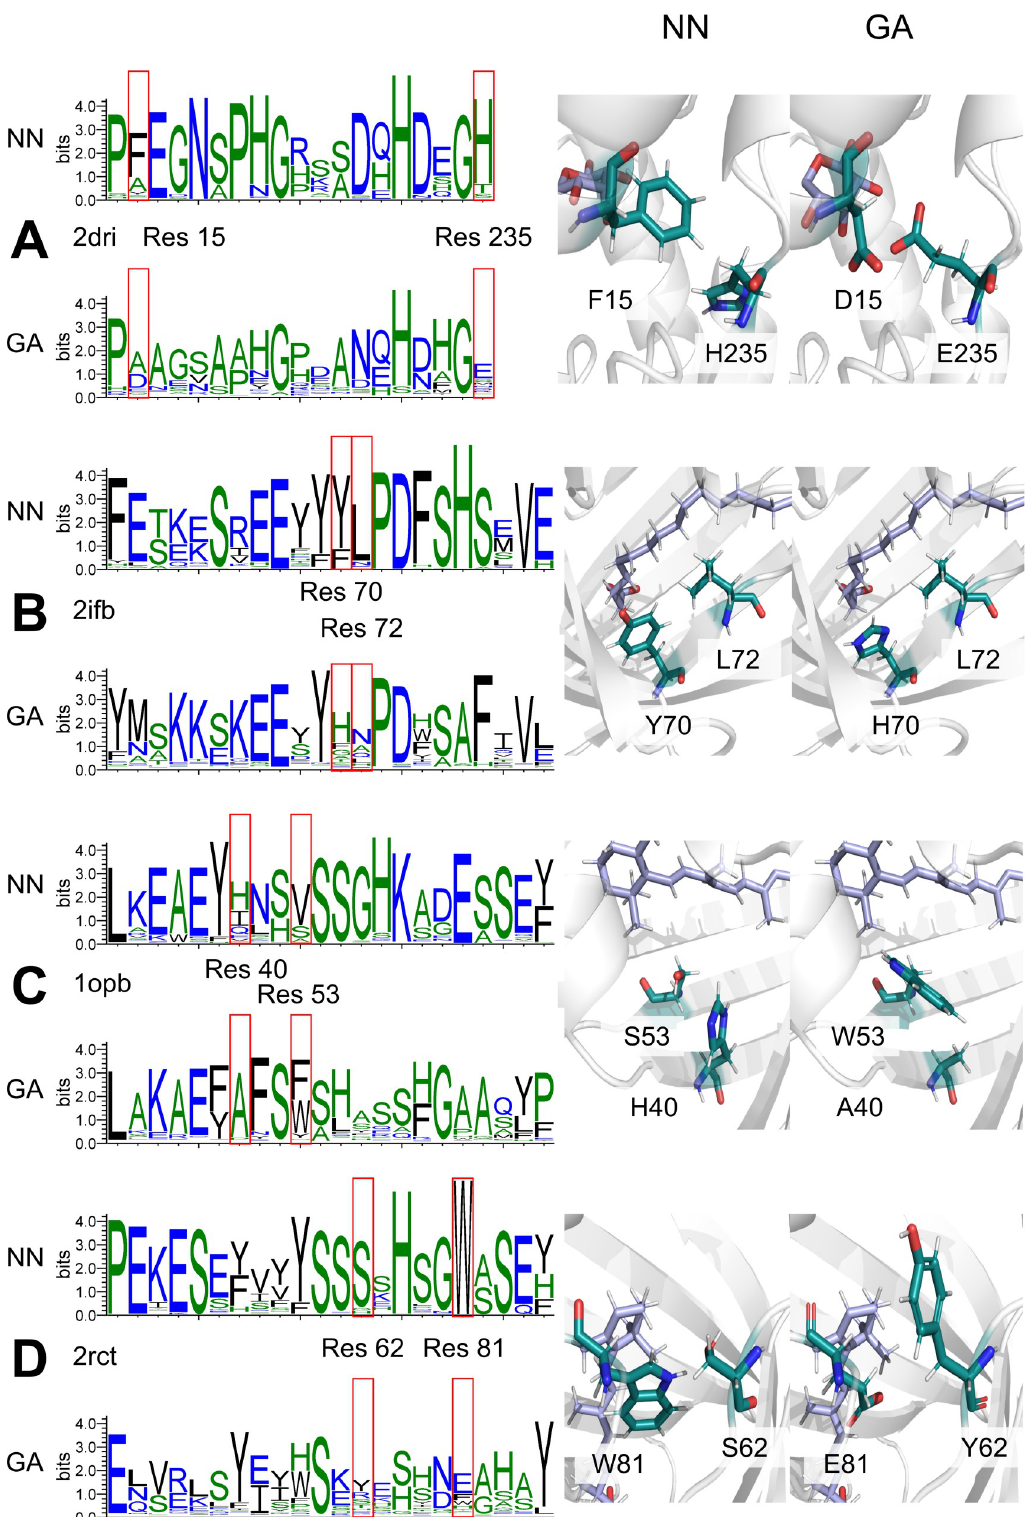
Fig 5. Residue occupancies generated by Rosetta:MSF:GA and Rosetta:MSF:NN for four design shells. For each design shell, the GA- and NN-specific logos resulting from the 239 sequences of generation 100 are given. In each case, one residue